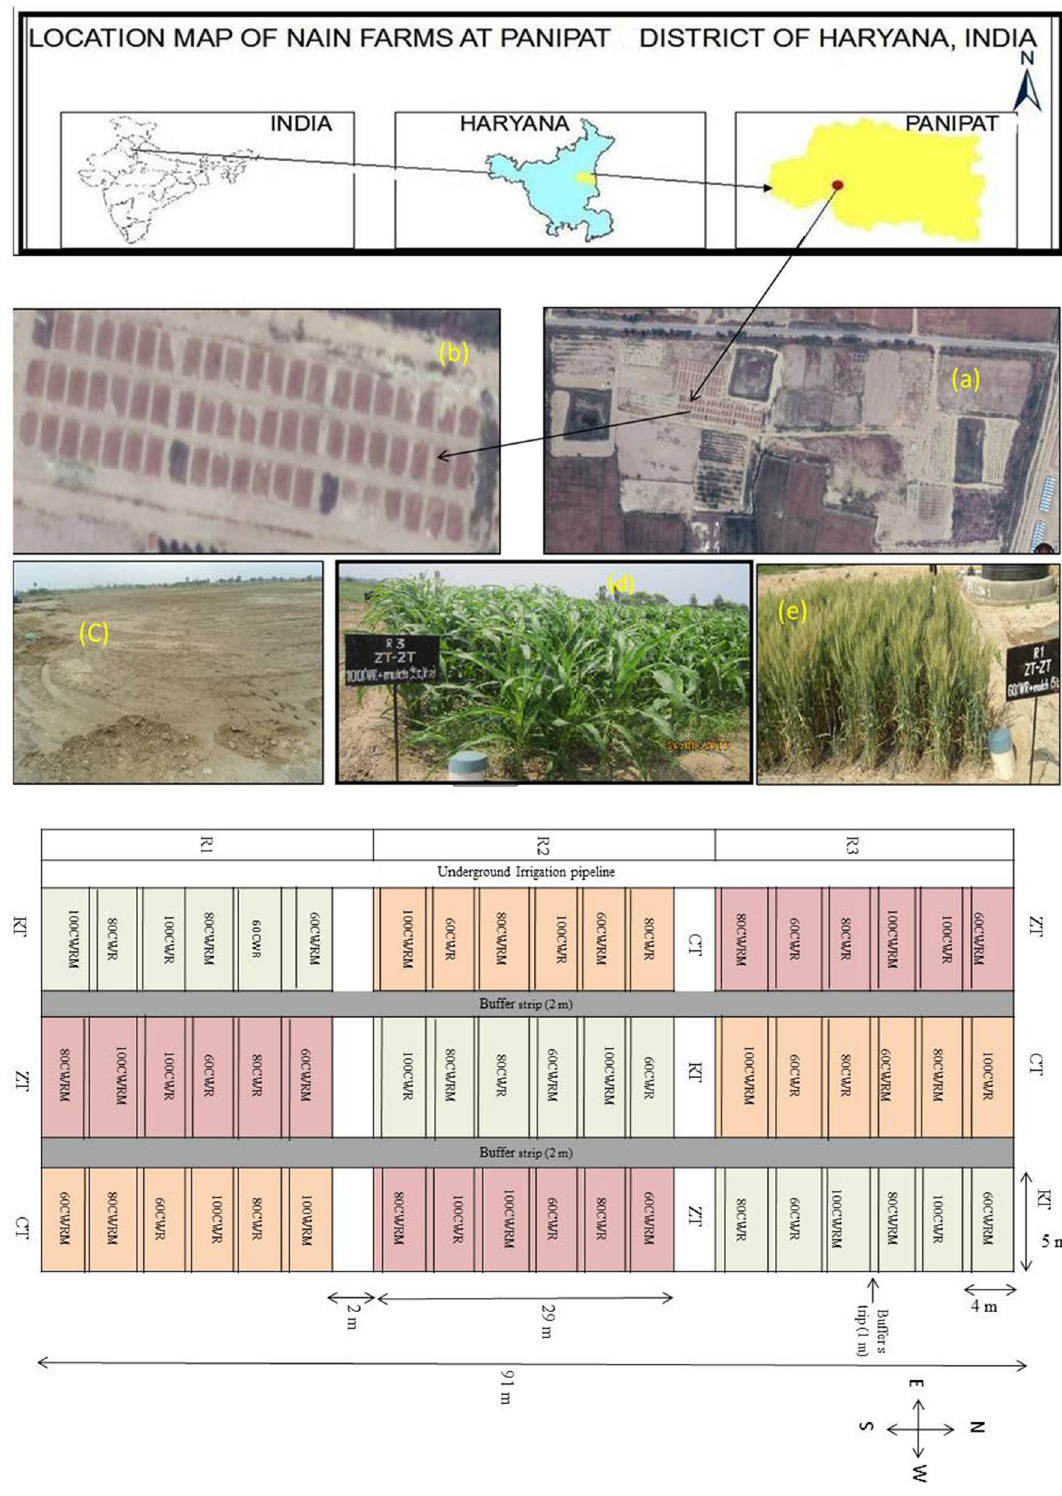
Figure 4. ( A ) Location map of field experiment at Panipat, Haryana, India; (a) CSSRI experimental Farm, Nain, Panipat, Haryana; (b) Experimental field; (c) Barren field before cultivation May 2014; (d) Kharif sorghum; (e) Rabi wheat; ( B ) Layout of field experiment. Main Plot: 29 m × 5 m; Sub-plot: 4 m × 5 m; between main plot 2 m buffer strip; between two sub plot-buffer strip of 1 m; ZT, zero tillage; CT, conventional tillage; RT, reduced tillage; 100, 80 and 60, per cent water requirement of wheat crop, irrigation applied only in wheat, sorghum was grown as rainfed; M, 5 Mg ha −1 rice straw mulch applied during